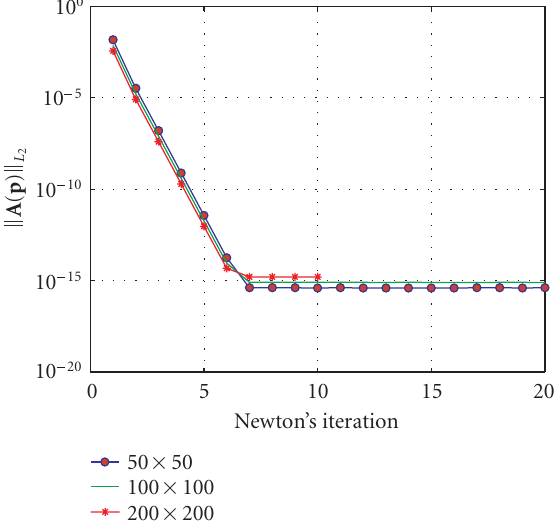
Figure 4.1 . Example 4.1: Newton’s iteration versus the residual norm (cid:4) A ( p ) (cid:4) L